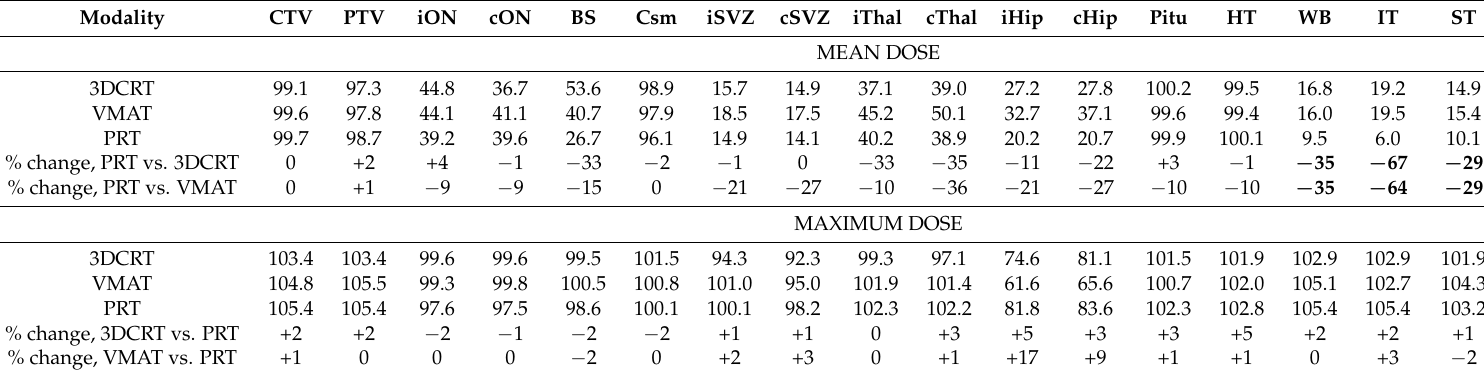
Table 3. Median values for mean and maximum doses to target volumes and organs-at-risk by radiotherapy modality for suprasellar tumors.